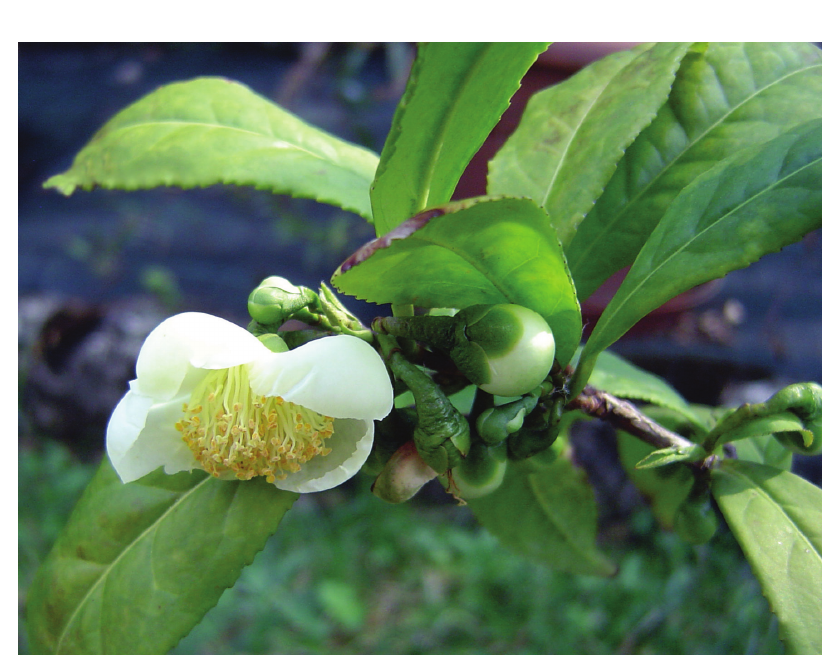
Figure 15. Camellia sinensis Kuntze: leaves and